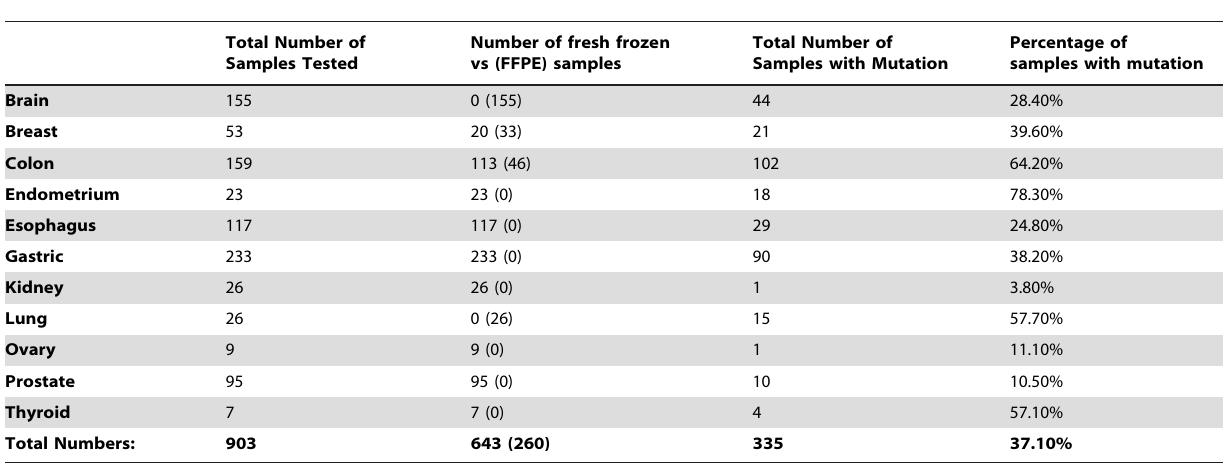
Table 1. Human tumor samples (fresh frozen and FFPE) investigated in this study.